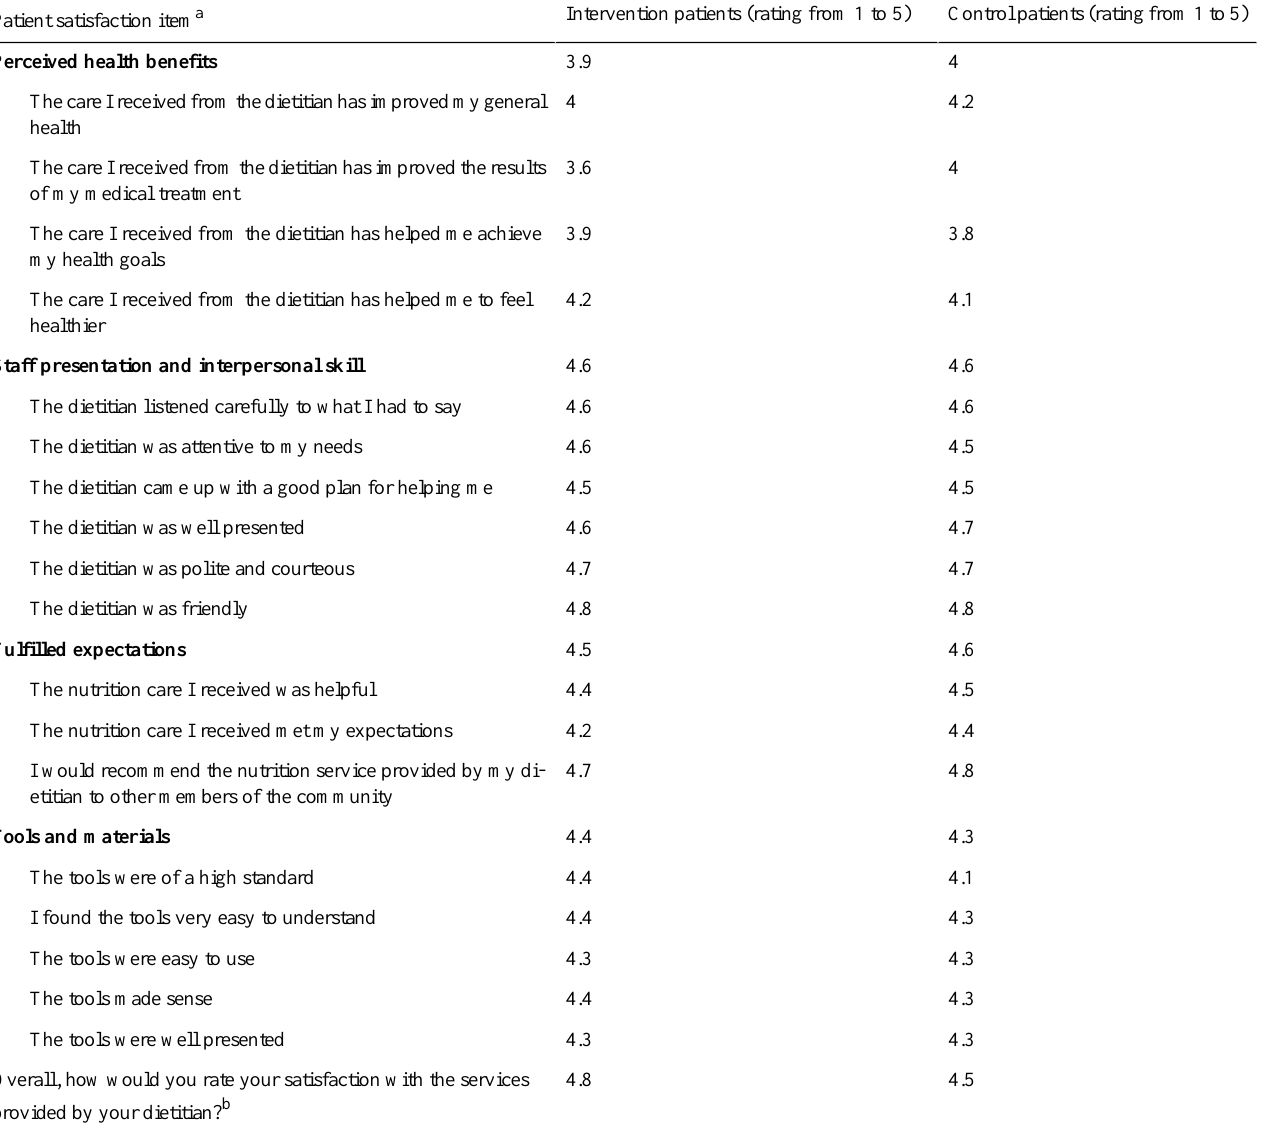
Table 4. Patient satisfaction ratings with dietetic